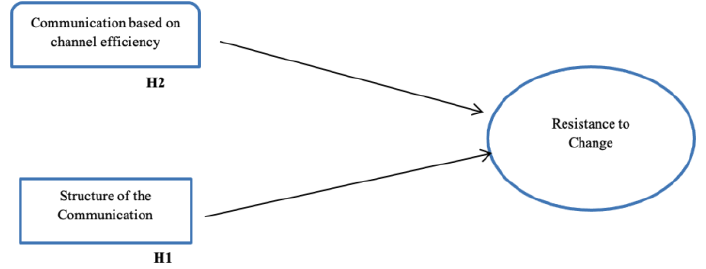
Figure 1: Change Communication Adequacy